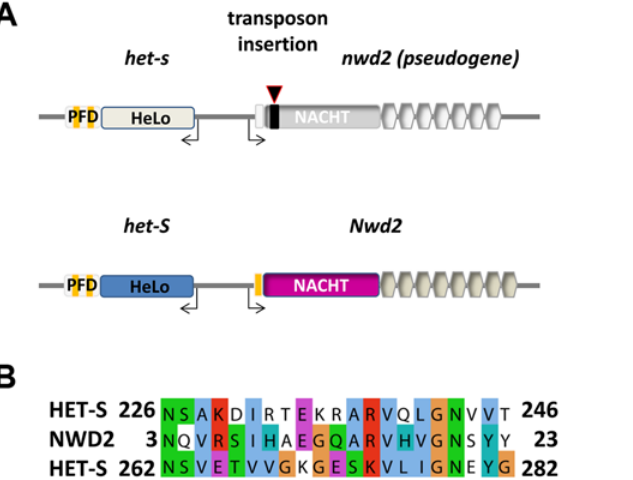
Fig 1. Genomic organization of the Nwd2/het-S locus and homology between the HET-S PFD region and the N-terminal region of NWD2. A. Gene structure at the het-s/Nwd2 locus in wild-type het-S and het-s strains. NWD2 is encoded by the gene immediately adjacent to het-S in the genome. The two genes are divergently transcribed. Open reading frames are separated by 0.6 kb. In het-s wild-type strains, nwd2 contains a repa transposon scar corresponding to an approximately 0.5 kb insertion, leading to premature stop codons; nwd2 is thus in an inactive pseudogene form in all wild-type het-s strains (after [14,24]). B. Sequence alignment of the NWD2 N-terminal region (3 – 23) and the first (226 – 246) and second 21 amino acid repeat (262 – 282) of the prion-forming region of HET-S. show that a NWD2(1 – 30)-GFP (Green Fluorescent Protein) fusion protein is able to induce ac- tivation of HET-S toxicity. Our results show that NWD2 can act as a heterologous template for HET-S/s PFD transconformation and establish transmission of this prion fold as a mechanism of signal transduction by which a fungal Nod-like receptor activates a downstream cell death execution protein.